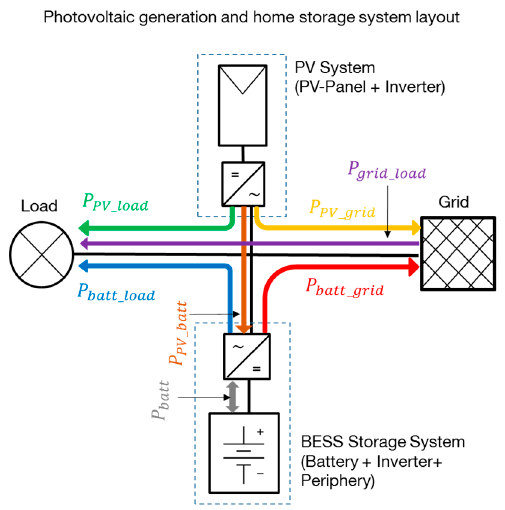
Figure 1. Schematic illustration of the investigated alternate current (AC) topology photovoltaic-battery energy storage systems coupling. Arrows indicate the direction of possible power flows between the individual components.